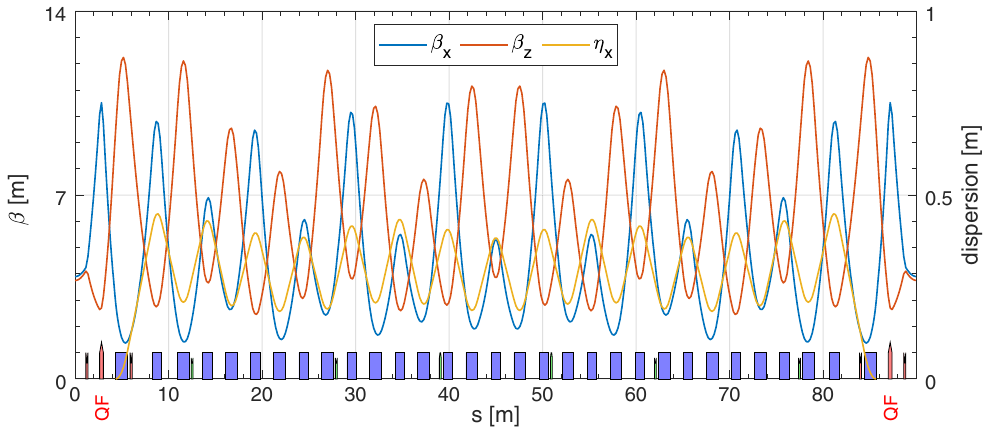
FIG. 9. Optical functions of a SLS Booster superperiod equal to one third of the ring circumference. The regular FODO cell optics is modulated to ease the matching and dispersion suppression into the straight section. The positions of the QF quadrupoles used for tune changes are marked in red.